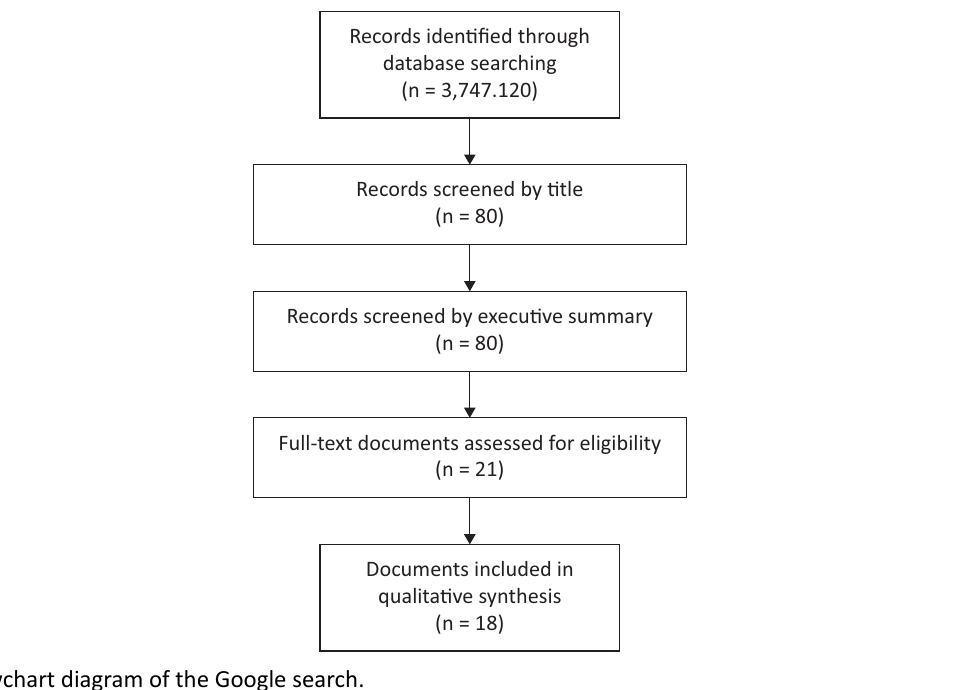
Figure 2. Flowchart diagram of the Google